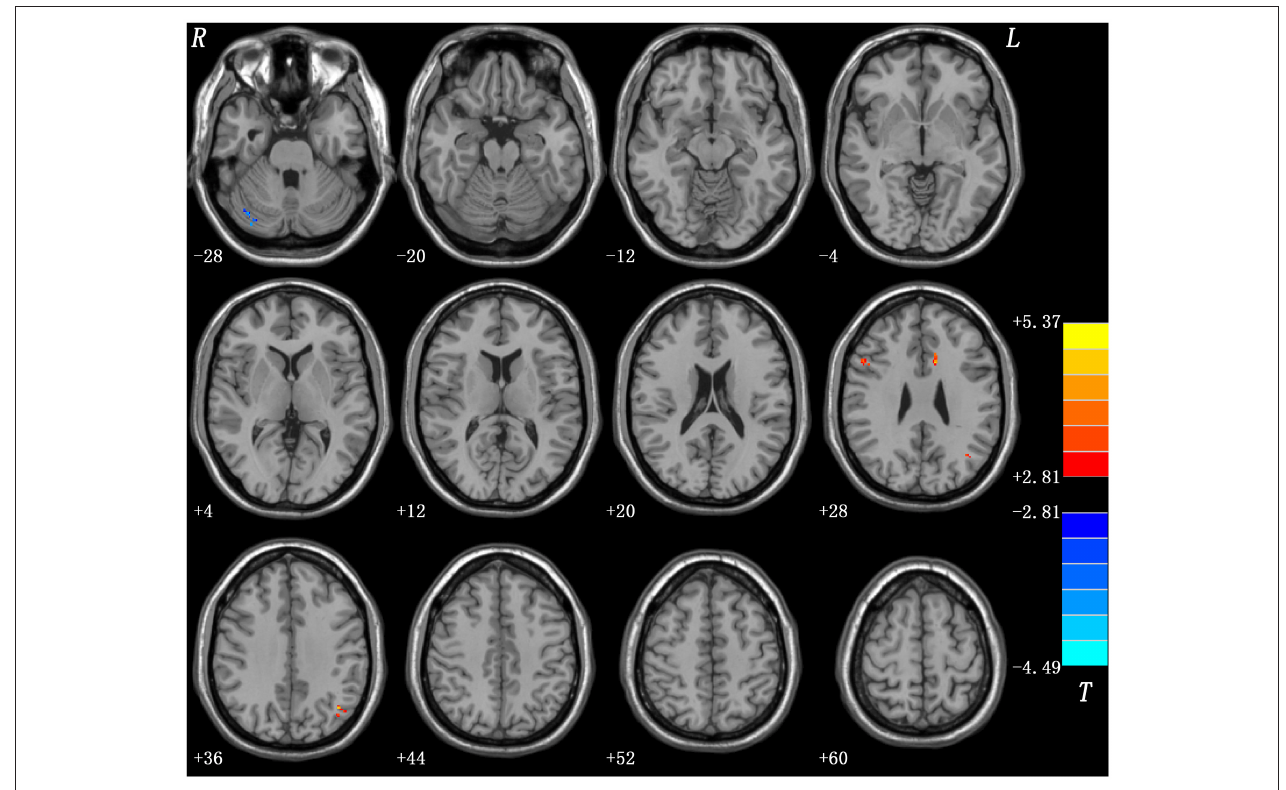
FIGURE 2 | Regions with abnormal gray matter volume in the